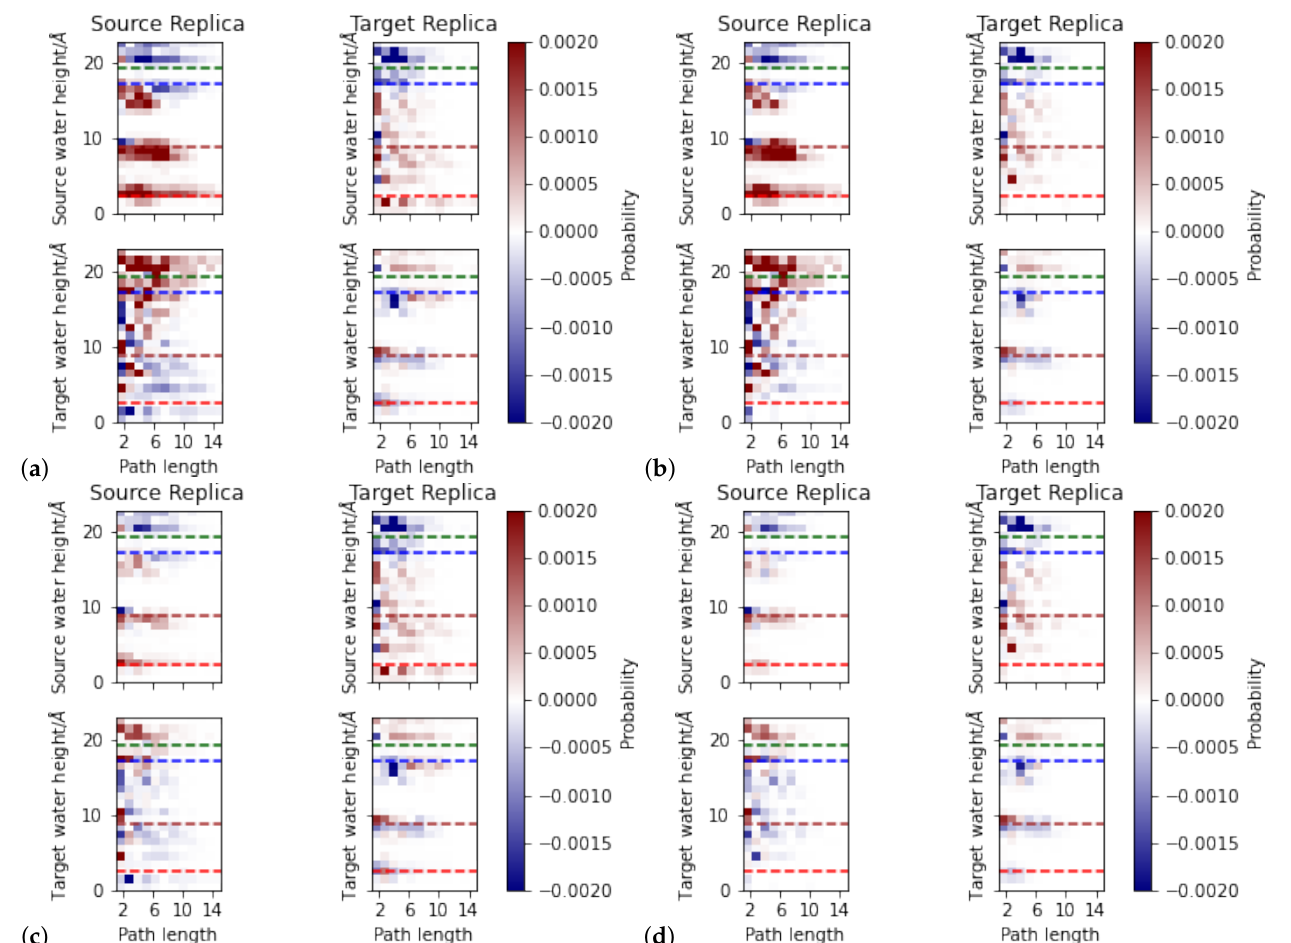
Figure 10. Difference in position-dependent acceptance for proton exchange between “downwards” (direction from Y288 to H96) transitions and “upwards” (direction from H96 to Y288) transitions, as a function of the transition step size as measured by the length of the hydrogen-bonded chain in “down” models. Blue and negative signs represent more “downwards”, and red represents more “upwards” transitions. The probabilities for “upwards” and “downwards” are shown separately in supplementary Figure S6. Dashed lines indicate the average position of protein residues E101 (red), S365 (brown), K362 (blue), and T359 (green). Criteria for proton transfer acceptance other than energy: ( a ) existence of a hydrogen-bonded connection in the source replica, ( b ) existence of a directed hydrogen-bonded connection in the source replica, ( c ) existence of a directed hydrogen-bonded connection in the source replica, and ( d ) existence of a directed hydrogen-bonded connection in the source and target replica as additional